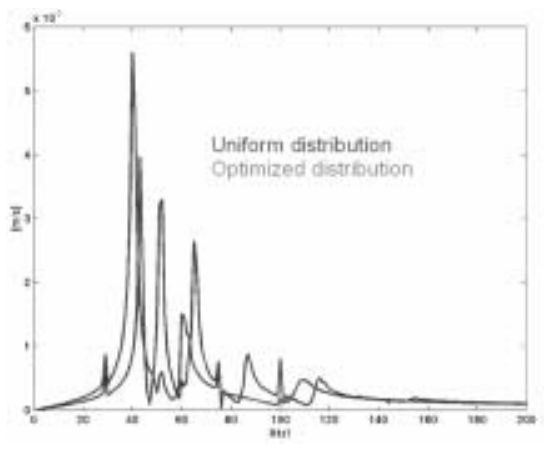
Fig. 11. Average velocity